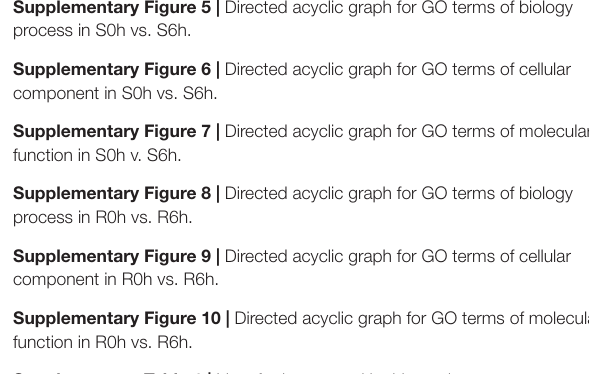
B21-a-2-1-2 for 7 days. Supplementary Figure 2 | A correlation coefficient analysis of samples. Supplementary Figure 3 | Principal components analysis of samples. Supplementary Figure 4 | Volcano diagram analysis of DEGs. Supplementary Figure 5 | Directed acyclic graph for GO terms of biology process in S0h vs. S6h. Supplementary Figure 6 | Directed acyclic graph for GO terms of cellular component in S0h vs. S6h. Supplementary Figure 7 | Directed acyclic graph for GO terms of molecular function in S0h v. S6h. Supplementary Figure 8 | Directed acyclic graph for GO terms of biology process in R0h vs. R6h. Supplementary Figure 9 | Directed acyclic graph for GO terms of cellular component in R0h vs. R6h. Supplementary Figure 10 | Directed acyclic graph for GO terms of molecular function in R0h vs. R6h. Supplementary Table 1 | List of primers used in this study. Supplementary Table 2 | Principal component analysis of samples. Supplementary Table 3 | List of DEGs in S0h vs. R0h comparison. Supplementary Table 4 | List of DEGs in S0h vs. S6h comparison. Supplementary Table 5 | List of DEGs in R0h vs. R6h comparison. Supplementary Table 6 | List of DEGs identified as the same expression trend in S0h vs. S6h, R0h vs. R6h, and S6h vs. R6h